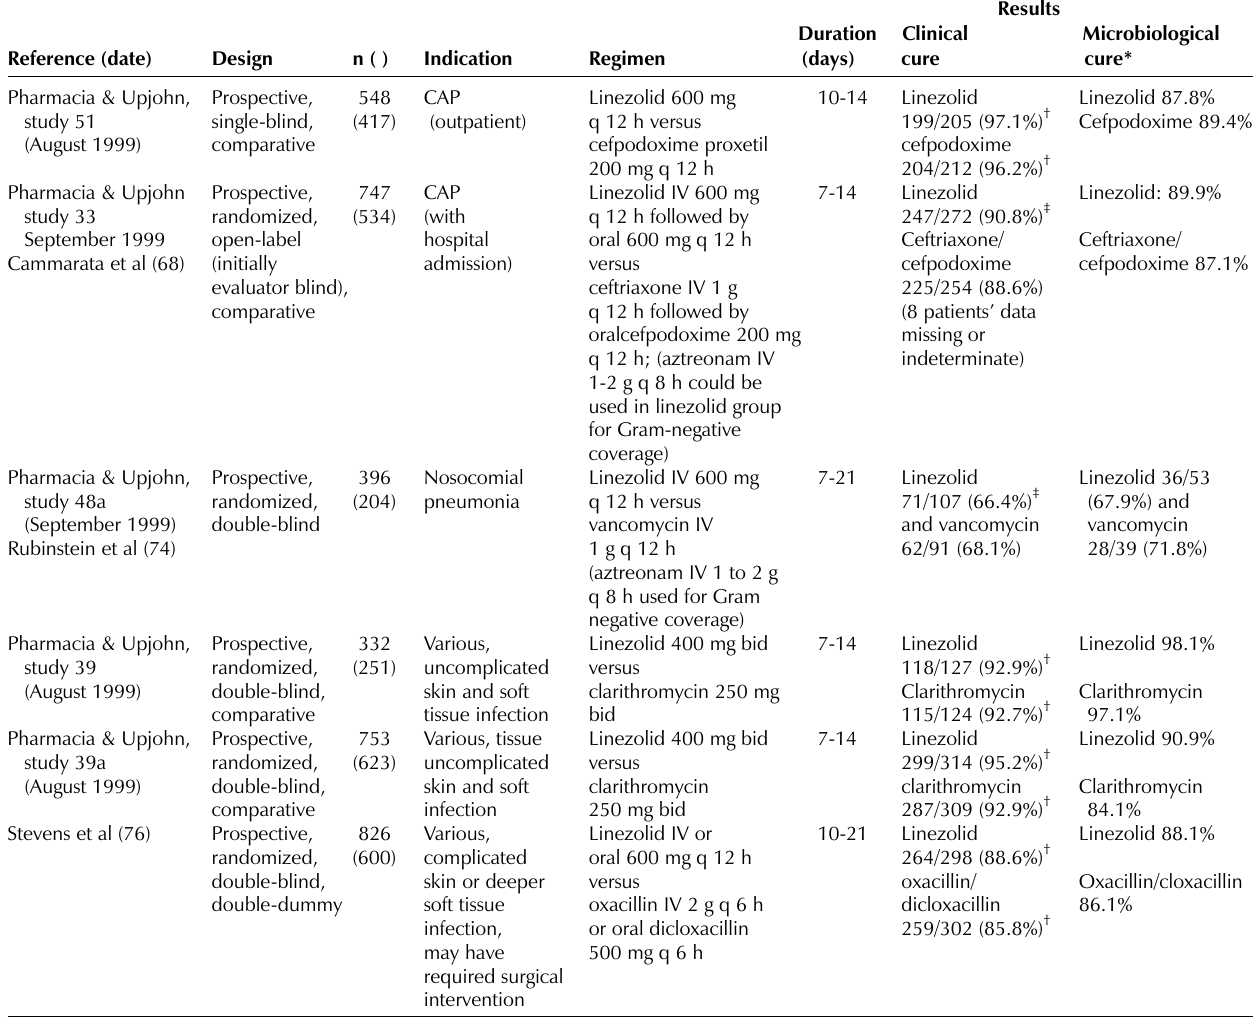
TABLE 6 Results of clinical trials involving linezolid in adults